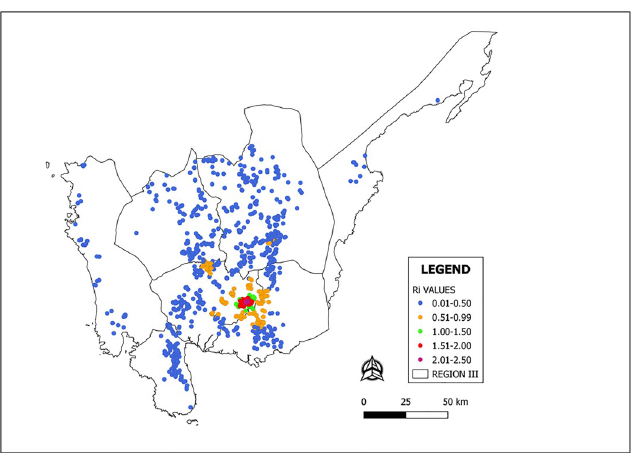
Fig 4. Risk map of HPAI transmission in Central Luzon, Philippines; a) map showing the provinces in Central Luzon (b) map showing the towns within the high risk